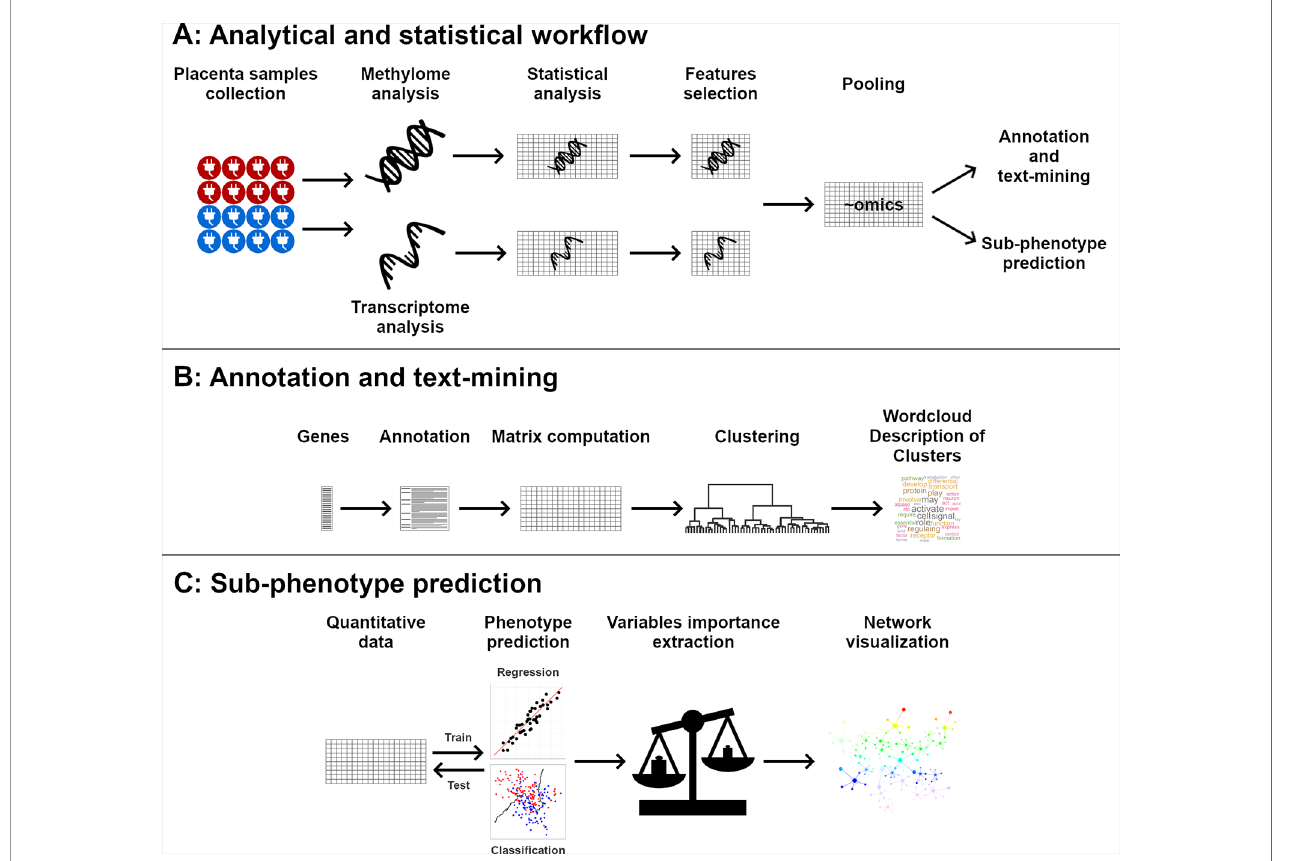
FIGURE 1 | Global work fl ow of the analysis. Placentas methylome and transcriptome were analyzed (A) . Signi fi cant genes were clustered and described using text annotations (B) . Quantitative data were used to predict phenotypic data, and the importance of each gene in phenotype prediction was visualized using networks (C)